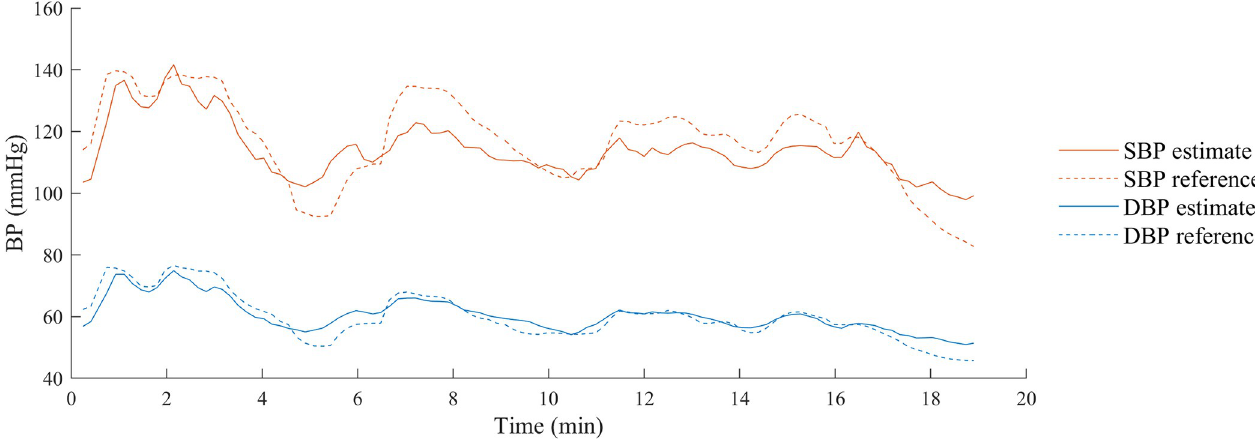
Fig 7. Temporal evolution of invasive reference and PPG-based BP estimation in a patient. Orange corresponds to SBP, while blue to DBP. The PPG-based BP estimations are shown by the solid lines. The invasive reference measurements are represented by the dashed lines.